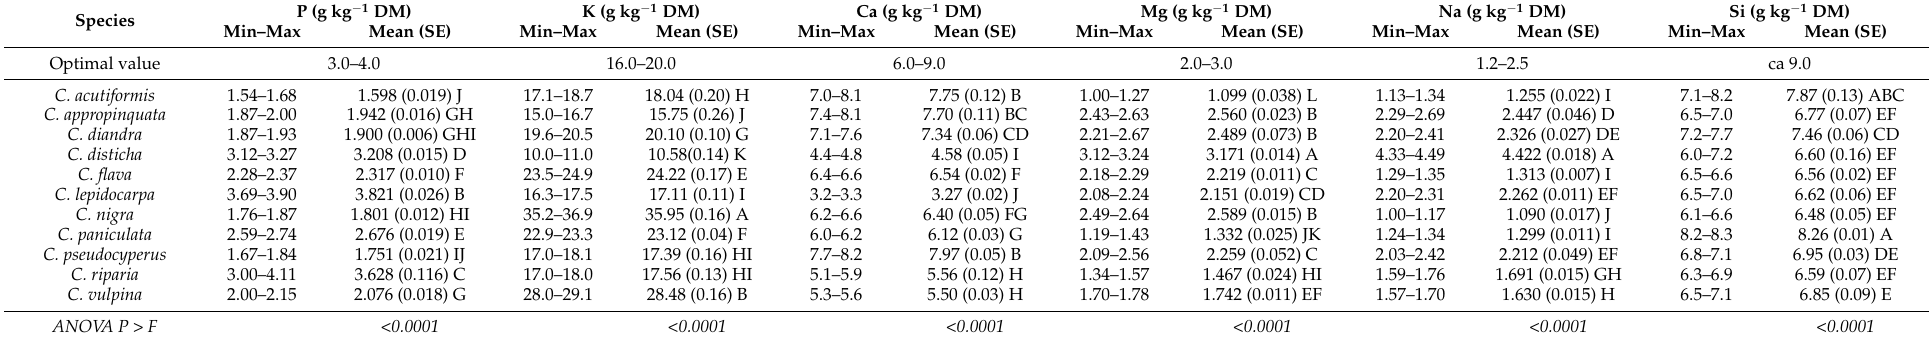
Table 5. Ranges (min–max) and mean values ( ± SE) of six major elements content in aboveground biomass of the Carex taxa. One way analysis of variance (ANOVA) were performed separately for each macroelement studied. The same letters indicate a lack of statistically significant differences among species analysed according to Tukey’s a posteriori test ( p < 0.05). Species